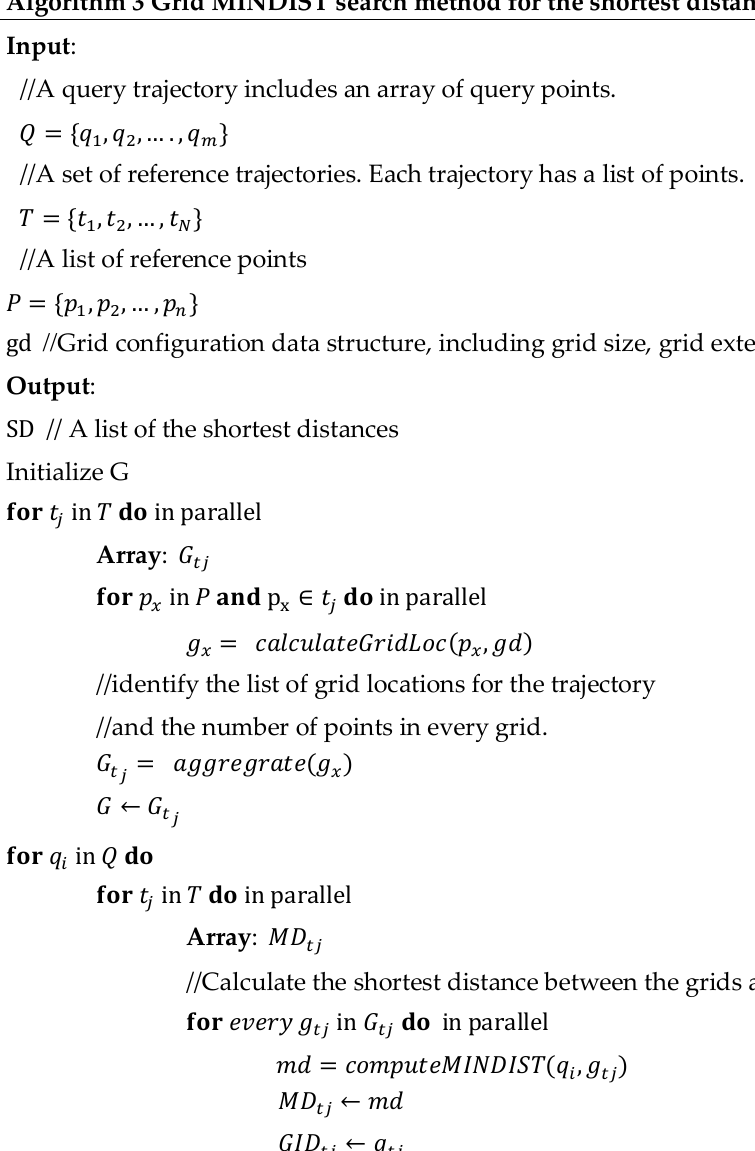
Algorithm 3 Grid MINDIST search method for the shortest distance computation